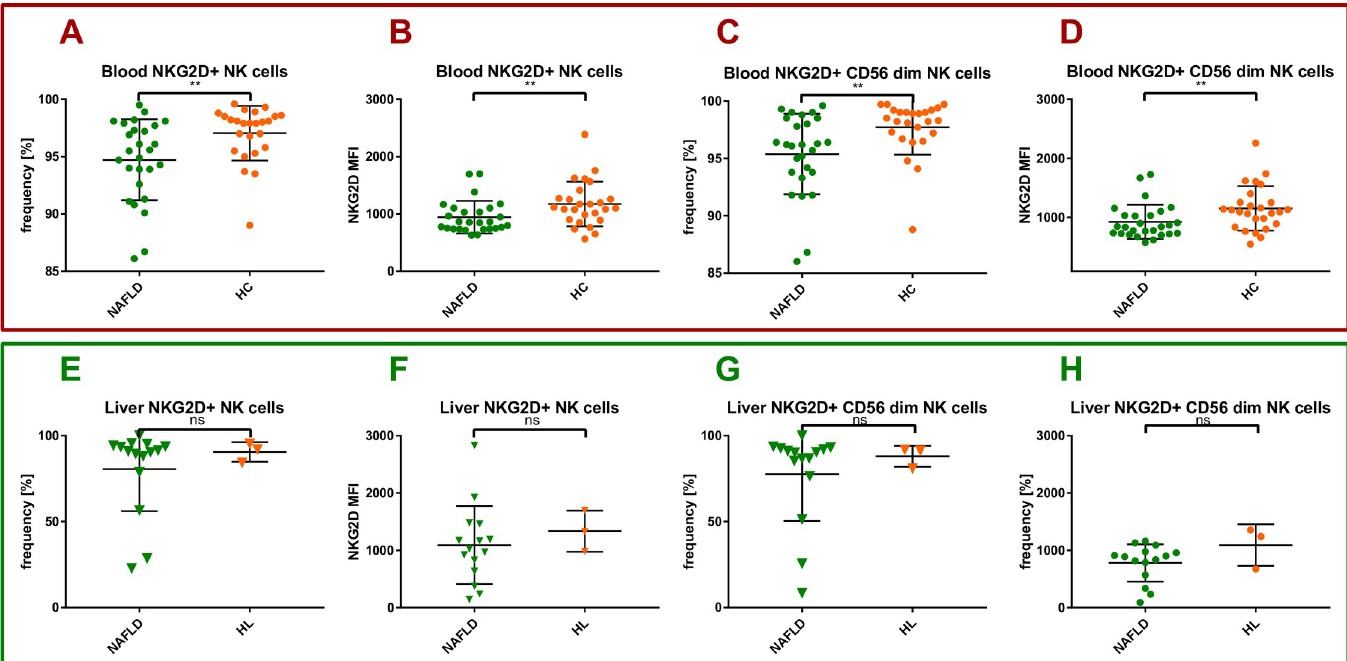
Fig 2. Peripheral and intrahepatic NKG2D positive NK cells in NAFLD. Healthy PBMC controls (HC), healthy liver controls (HL), NAFLD liver and PBMC samples (NAFLD), mean fluorescence intensity (MFI). Each spot represents one patient. (A-D) PBMC data. (E-H) intrahepatic data. (A) NKG2D+NK cell frequency in PBMCs of NAFLD patients compared to healthy controls. (B) NKG2D MFI of NK cells in PBMCs of NAFLD patients compared to healthy controls. (C) NKG2D+CD56dim NK cell frequency in PBMCs of NAFLD patients compared to healthy controls. (D) NKG2D MFI of CD56 dim NK cells in PBMCs of NAFLD patients compared to healthy controls. (E) NKG2D+ NK cell frequency in liver samples of NAFLD patients compared to healthy controls. (F) NKG2D MFI of NK cells in IHLs of NAFLD patients compared to healthy controls. (G) NKG2D+ CD56dim NK cell frequency in liver samples of NAFLD patients compared to healthy controls. (H) NKG2D MFI of CD56 dim NK cells in IHLs of NAFLD patients compared to healthy controls. For Comparisons Mann-Whitney test was used. � p < 0.05, �� p > 0.01.